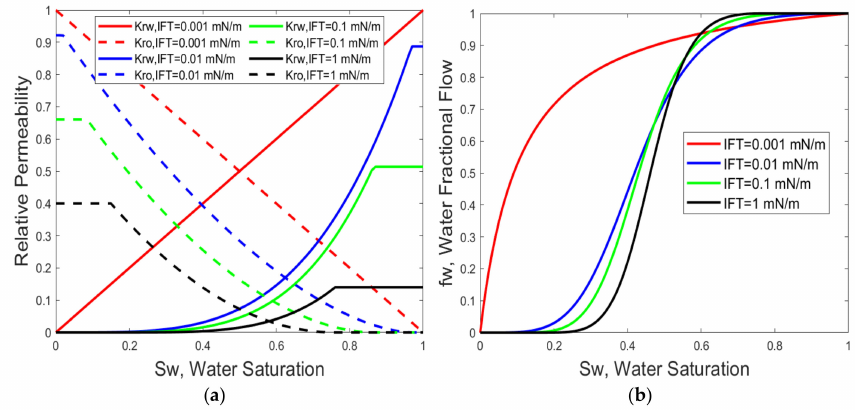
Figure 15. ( a ) Water / oil relative permeability; and (b) water fractional flow as a function of water saturation and interfacial tension